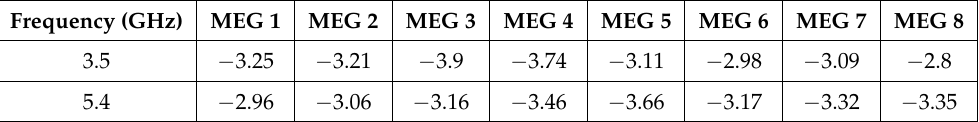
Table 1. Calculated MEG of the proposed MIMO